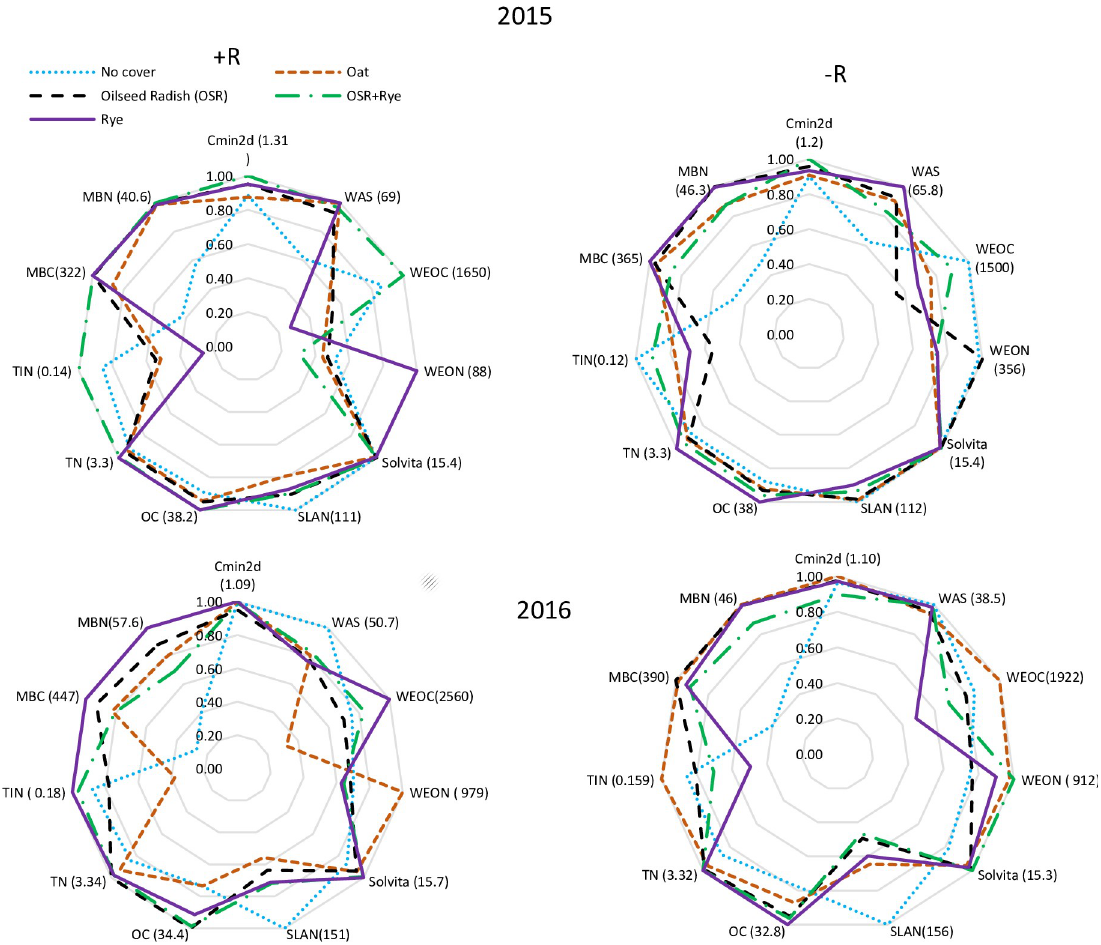
Fig 6. Effect of medium-term summer-planted cover crop (6-yrs) and crop residue retained (+R) (A,C) or removed (-R) (B,D) on soil labile and stable indicators of C and N at tomato harvest in site-year 2015 (A,B) and 2016 (C,D). Values in parenthesis represent mean (n = 4) maximum concentrations expressed as mg g -1 for Cmin 2d , OC, TIN, and TN; mg kg -1 for WEOC, WEON, Solvita, and SLAN; μ g g - 1 for MBC and MBN; % for WAS (Cmin 2d , cumulative 2d soil C mineralization; MBC, microbial biomass C; MBN, microbial biomass N; SLAN, Solvita labile amino N; OC, organic C; TIN, total inorganic N; TN, total N; WAS, wet aggregate stability; WEOC, water extractable organic C; WEON, water extractable organic